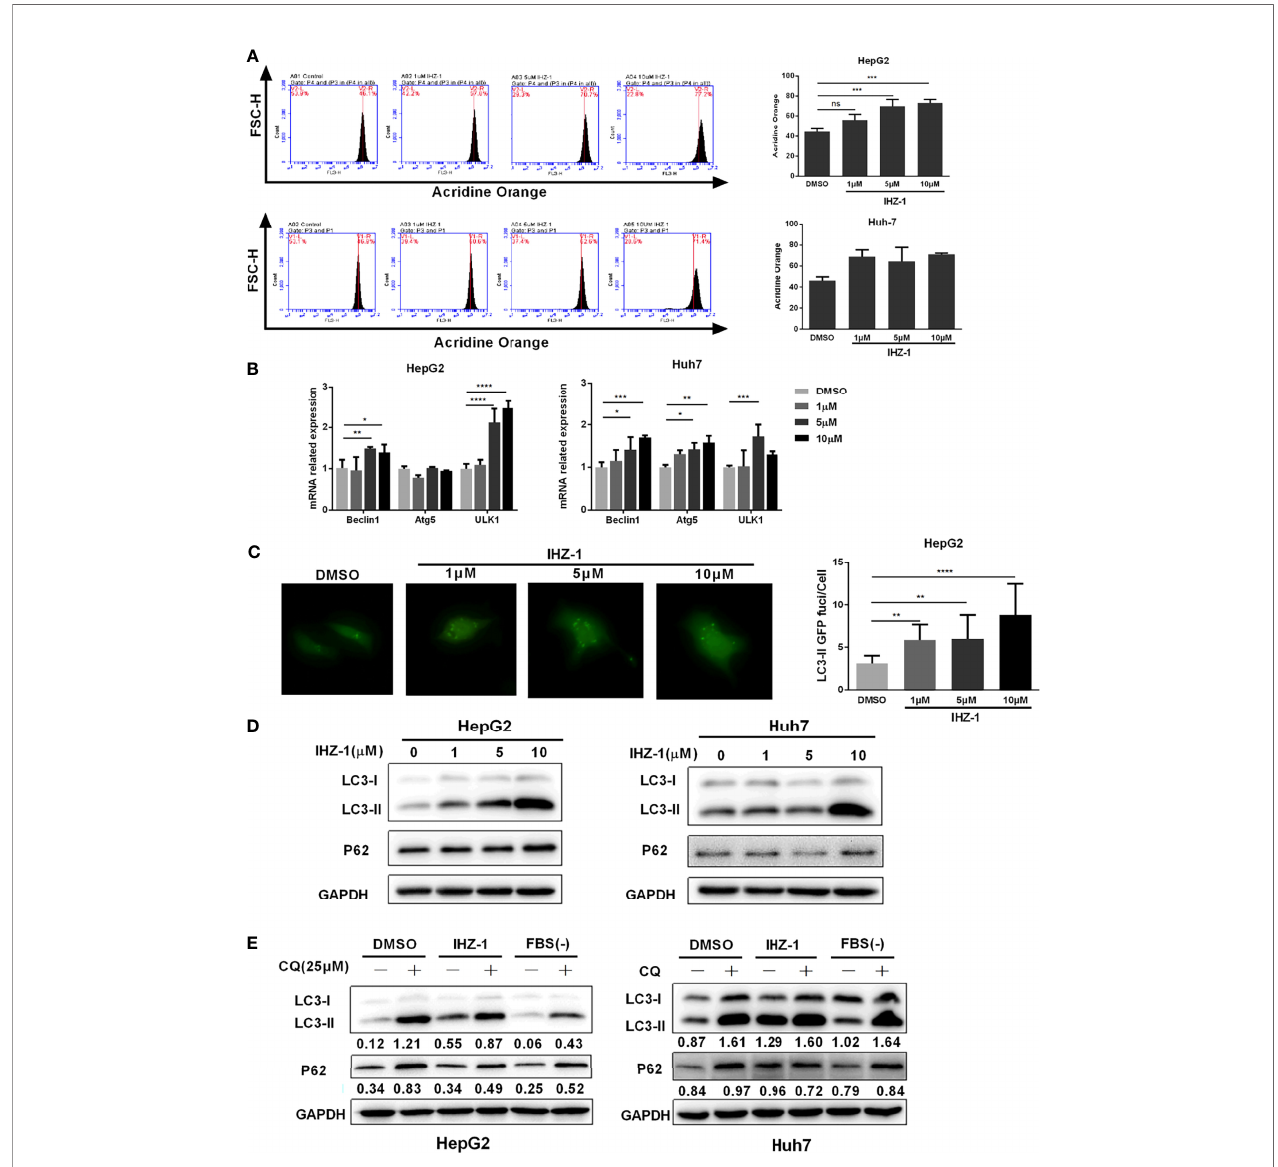
FIGURE 3 | IHZ-1 triggers autophagy. (A) The number of acidic organelles were evaluated by acridine orange staining and analyzed by fl ow cytometry. (B) The autophagy-related mRNAs were determined by real-time PCR. (C) Representative images of HCC cells steadily articulating GFP-LC3 after IHZ-1 treatment. (D) The autophagy-related proteins were determined by western blotting. (E) The autophagic fl ux was determined by immunoblot analysis of LC3-II and P62 levels in HCC cells incubated with IHZ-1 in the presence or absence of CQ. As indicated below each lane, the LC3-II/GAPDH and P62/GAPDH ratios were determined using the ImageJ software. *p < 0.05, **p < 0.01, ***p < 0.001, and ****p < 0.0001. no signi fi cance